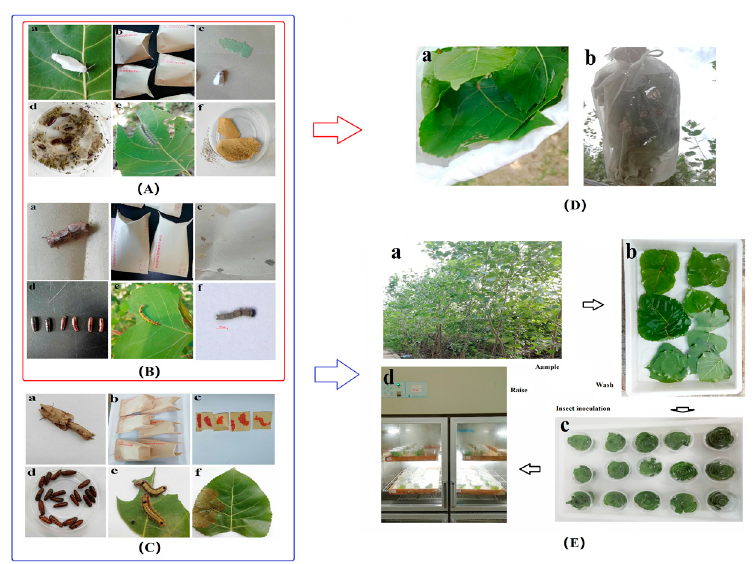
Figure 1. Experiments with target insects. ( A ) Acquisition of H. cunea ; a: mating, b: bagging, c: